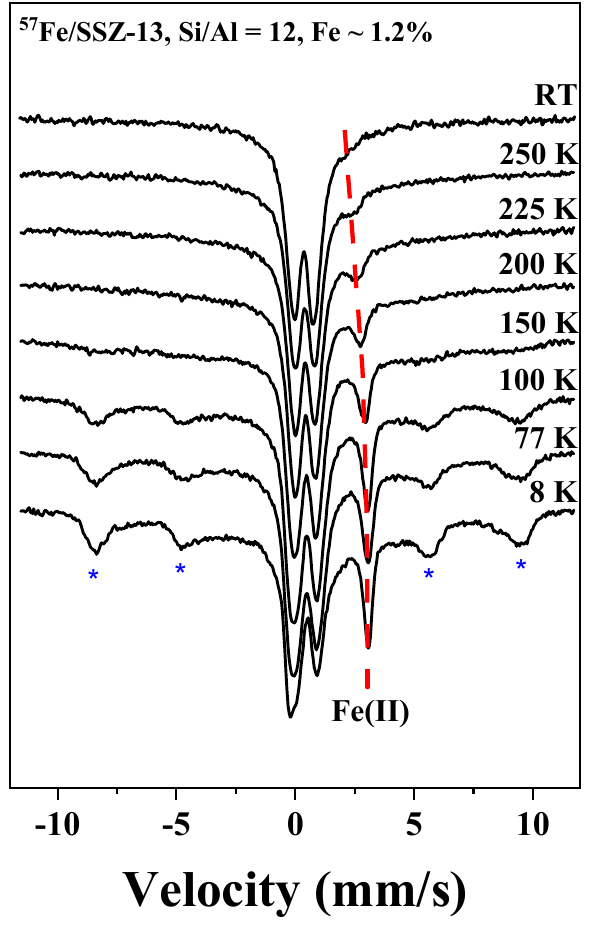
Figure 6. Mössbauer spectra of the ambient 57 Fe/SSZ-13 (1.20 wt%) sample measured at different temperatures, from 8 K to room temperature. Reprinted with permission from [54]. Copyright © 2017 Elsevier Inc. Magnetic Fe(III) sextets (marked with